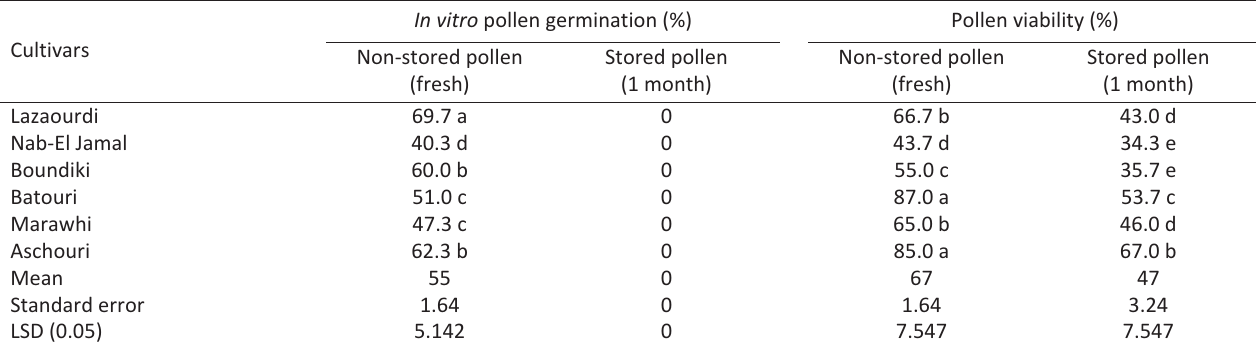
Data with the same letter in each column are not significantly different (least significant difference